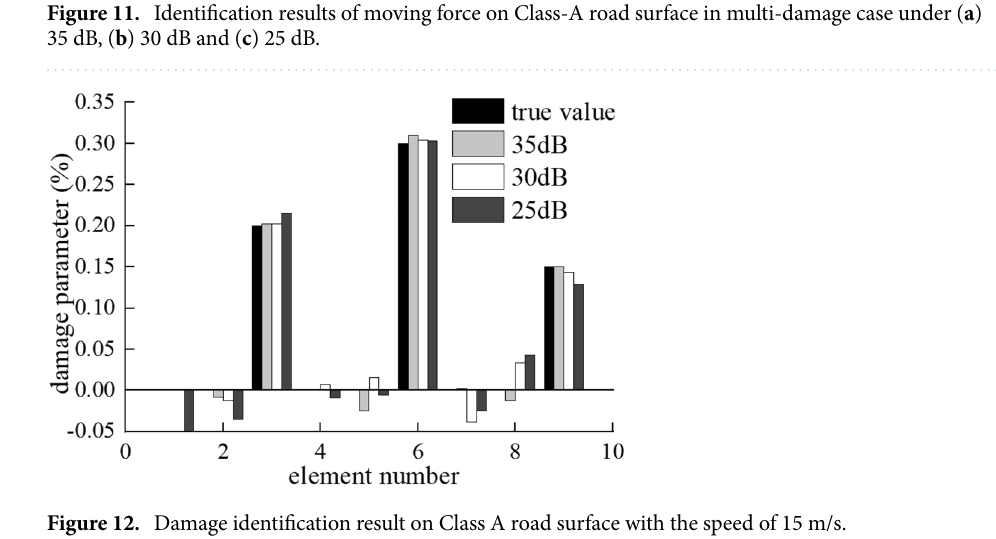
Figure 12. Damage identification result on Class A road surface with the speed of 15